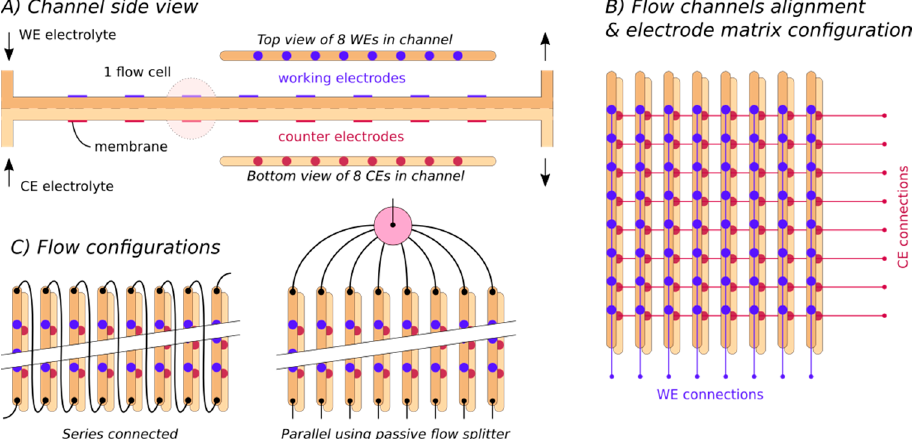
Figure 1. Schematic depiction of the HT setup. ( A ) Side view of a single channel, with anolyte and catholyte flowing from left to right, past eight CEs or WEs, respectively. ( B ) Top view of all channels, showing the electrical connections to all 64 electrodes. ( C ) Top view of all channels, showing two distinct flow configurations (left is series connected, right is parallel connected).